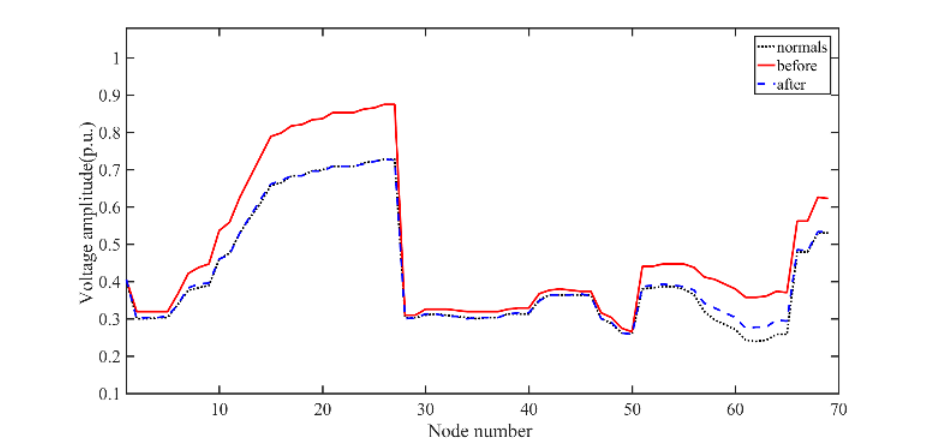
Fig. 7. Voltage distribution of the system before and after short-term optimization.